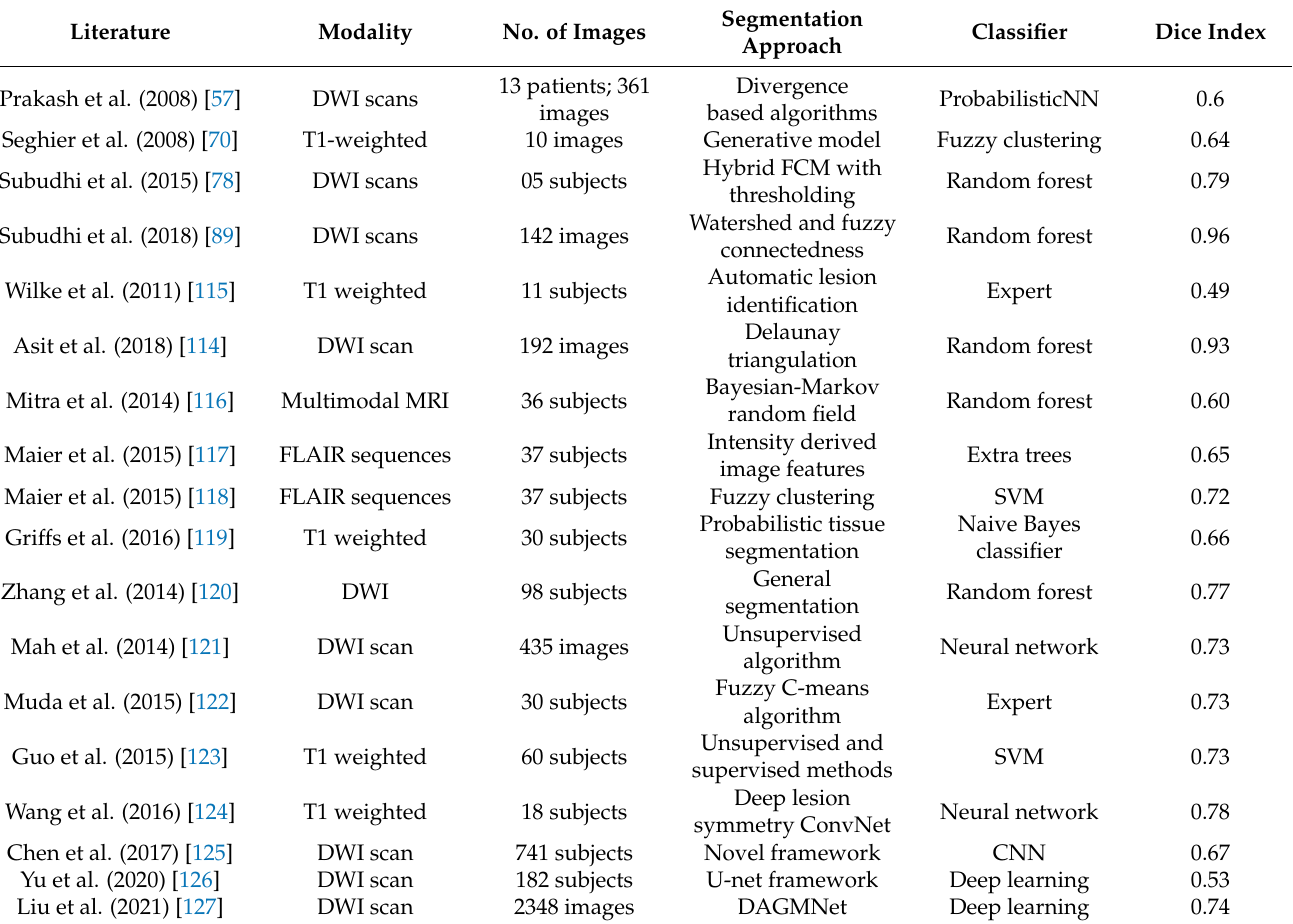
Table 1. Machine learning studies on detection of acute ischemic stroke